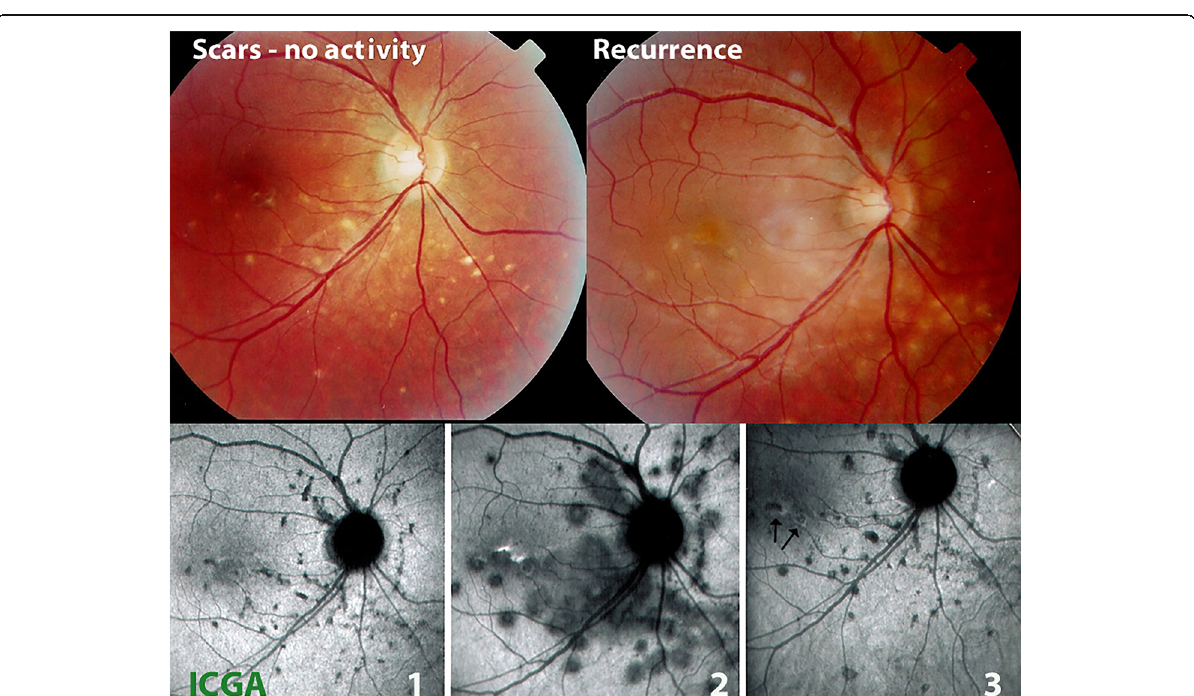
Fig. 2 Multifocal choroiditis (MFC) Fundus pictures (top two images): on the left picture, multiple yellow punched-out foci typically seen in MFC (inactive stage); on the right picture, additional new more fluffy lesions during recurrence. ICGA pictures (bottom), during inactive cicatricial stage (1), during reactivation (2), and after treatment (3); almost no additional scars. (Partially reprinted from Diagnostics (Basel). 2021 May 24;11 (6):939.